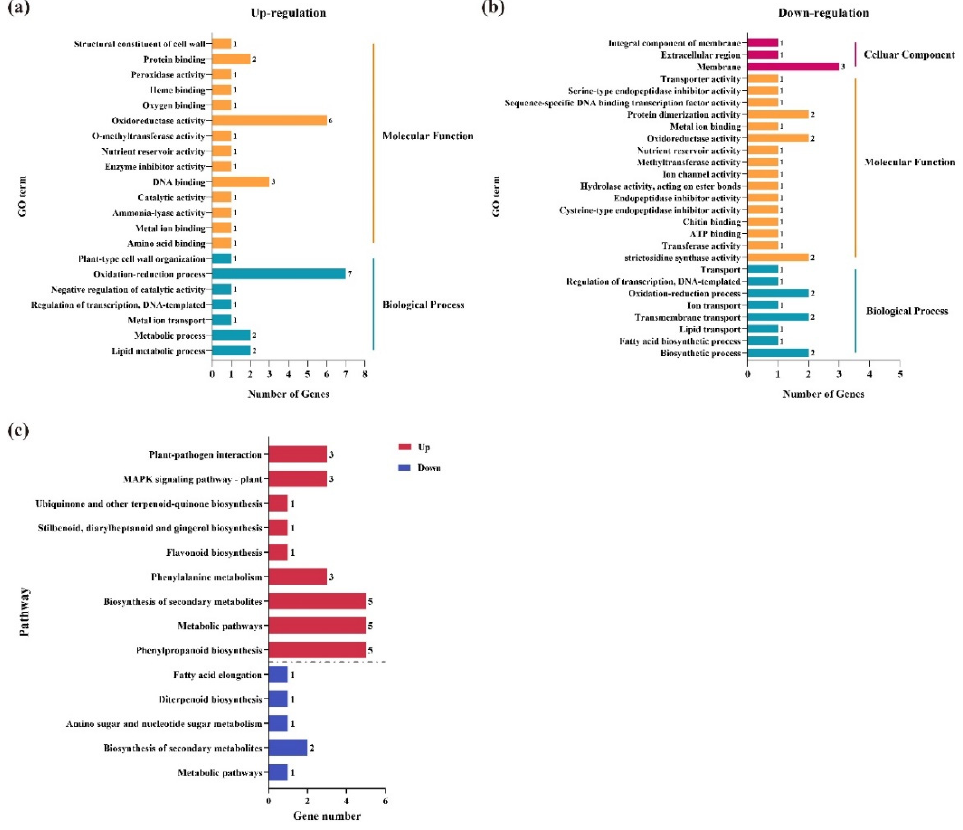
Figure 4. GO and KEGG enrichment analysis of the DEGs under all three different comparisons. The numbers of significantly up-regulated ( a ) and down-regulated ( b ) genes annotated with different GO terms under all three developmental stages are shown. ( c ) Classification of enriched KEGG pathways under the three developmental stages.